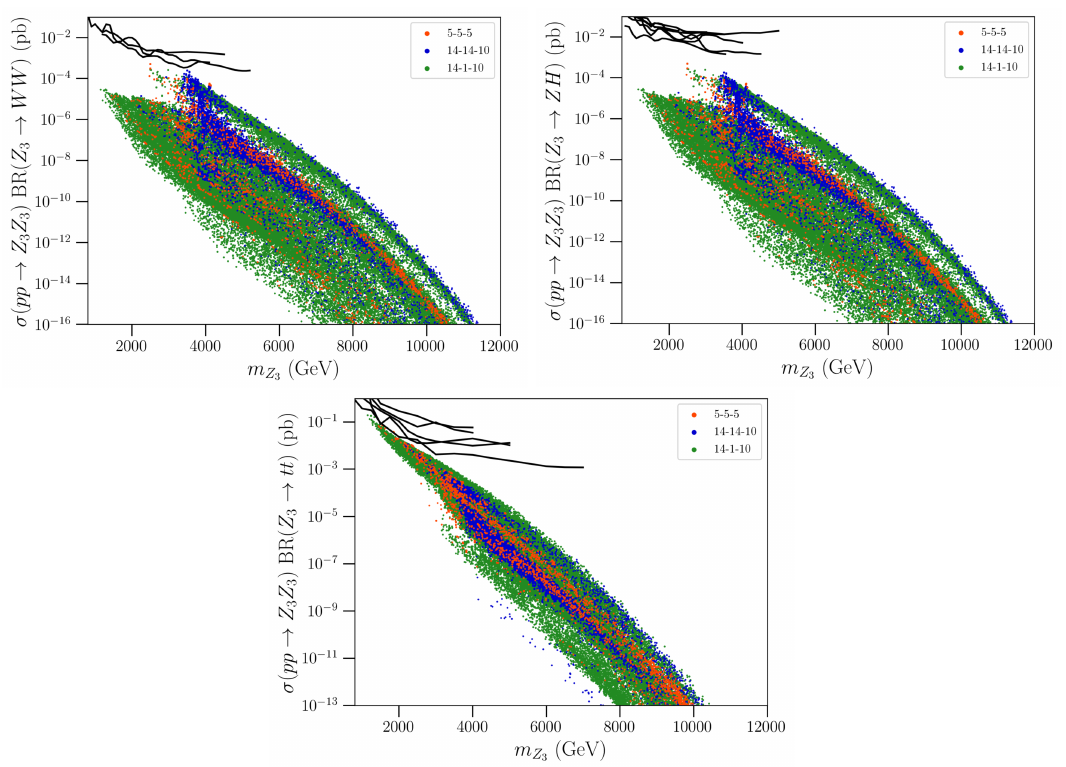
Figure 15. Cross sections for decays of the lightest neutral composite vector boson Z 3 into SM √ final states at s = 13 TeV for valid points in each model. Black lines mark the 95 % CL upper bounds taken as